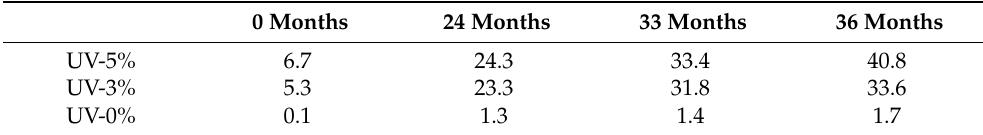
Table 3. Mean values of calculated film transmissivity, % in 300–380 nm wavelength range (laboratory